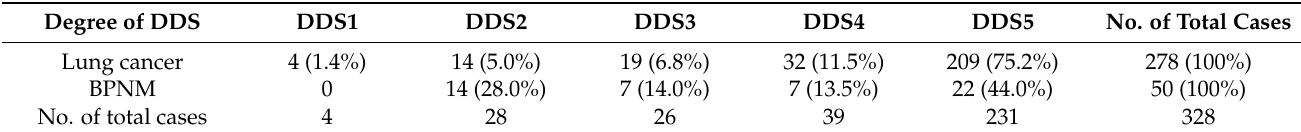
Table 3. Relationships between diffusion detectability scores (DDSs) and lung cancer /BPNMs.